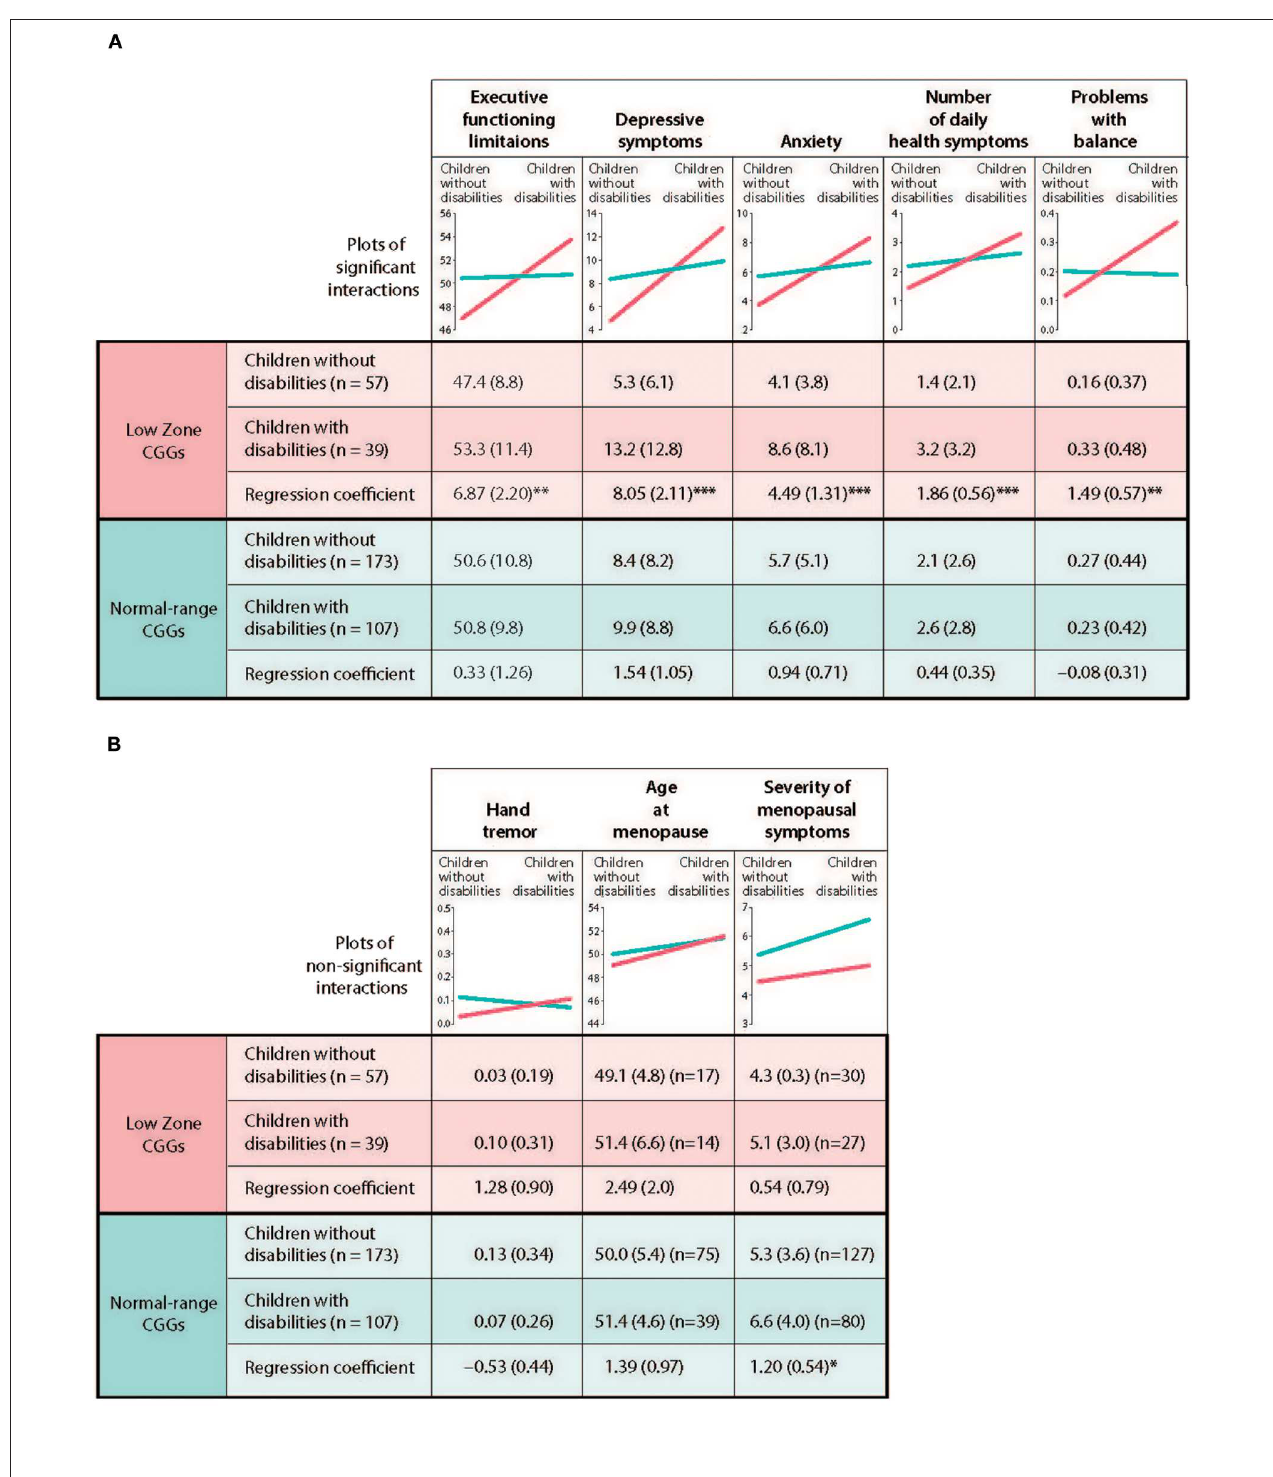
FIGURE 3 | Test of differential susceptibility for mothers. (A) Outcomes with differential susceptibility established. (B) Outcomes with differential susceptibility not established. * p < 0.05, ** p < 0.01, *** p < 0.001. a Unadjusted means are present with standard deviations in parenthesis. Unstandardized regression coefficients are presented with standard errors in